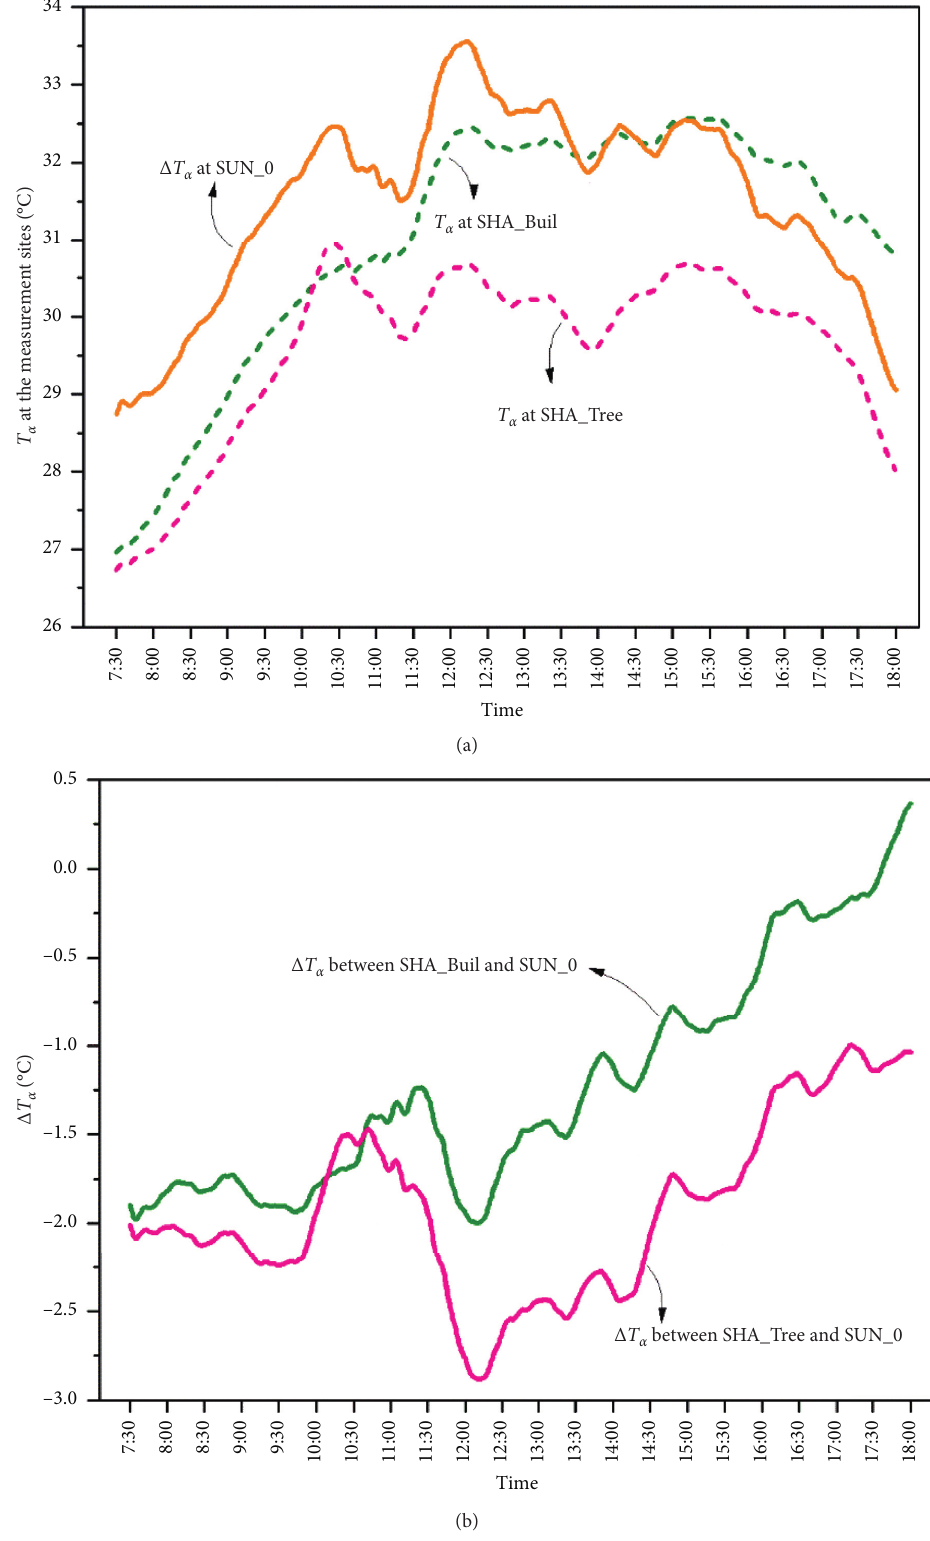
Figure 4: Diurnal patterns of T a and Δ T a on July 29, 2018: (a) temporal variation in T a at the shaded and sunlit areas; (b) Δ T a between the two shaded and the sunlit background meteorological